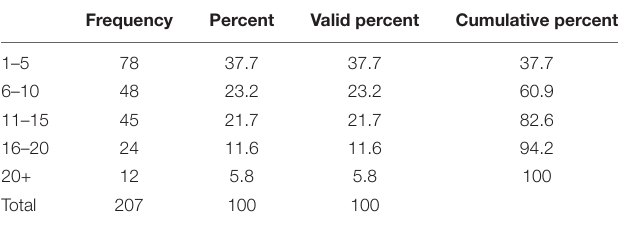
TABLE 3 | Years of teaching experience.